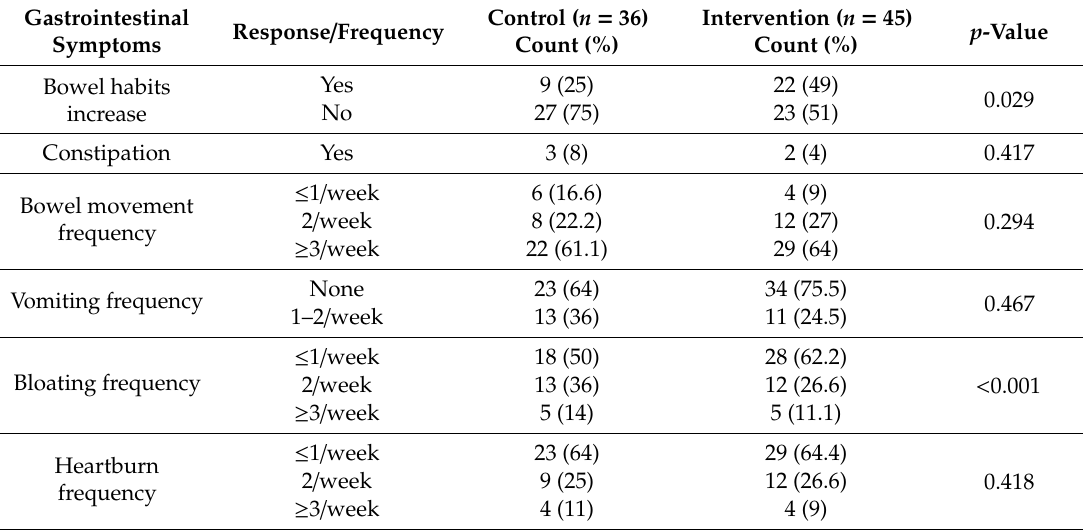
Table 2. Gastrointestinal symptoms experienced at the endpoint of Ramadan.